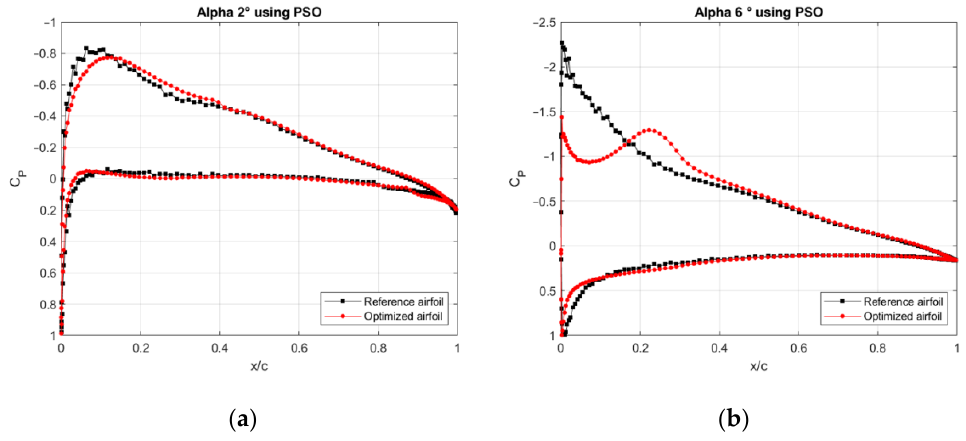
Figure 5. Cp distribution versus chord length using the PSO algorithm for the ( a ) angle of attack of 2° and ( b ) of 6°, compared to the reference airfoil.